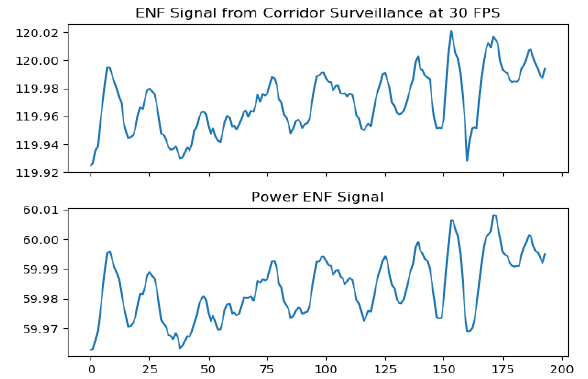
Figure 7. Comparing estimated ENF from Corridor Video Surveillance recording and parallel Power ENF recording.